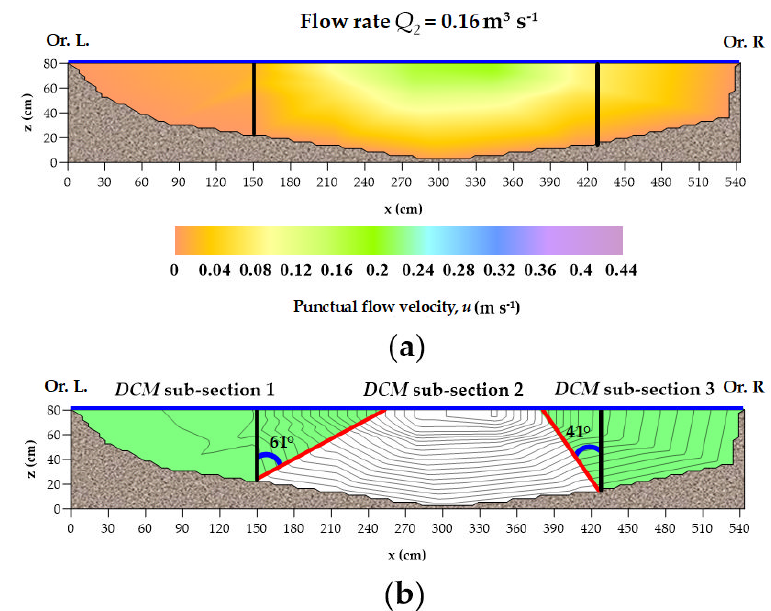
Figure 7. ( a ) Flow velocity field u (m · s − 1 ) for the Q 2 ( = 0.16 m 3 · s − 1 ) flow rate regime; ( b ) divided channel method (DCM) sub-sections. The continuous dark blue line indicates the water level at bankfull. The continuous vertical black lines indicate the boundary of the side buffers of undisturbed riparian vegetation, while the red lines represent the borders of the DCM sub-sections, in which slopes were equal to 61° and 41°, respectively referred to DCM sub-section 1 and DCM sub-section 3 (light green regions in Figure 7b). (From Lama et al. [3], modified). Geosciences 2020 , 10 , 47